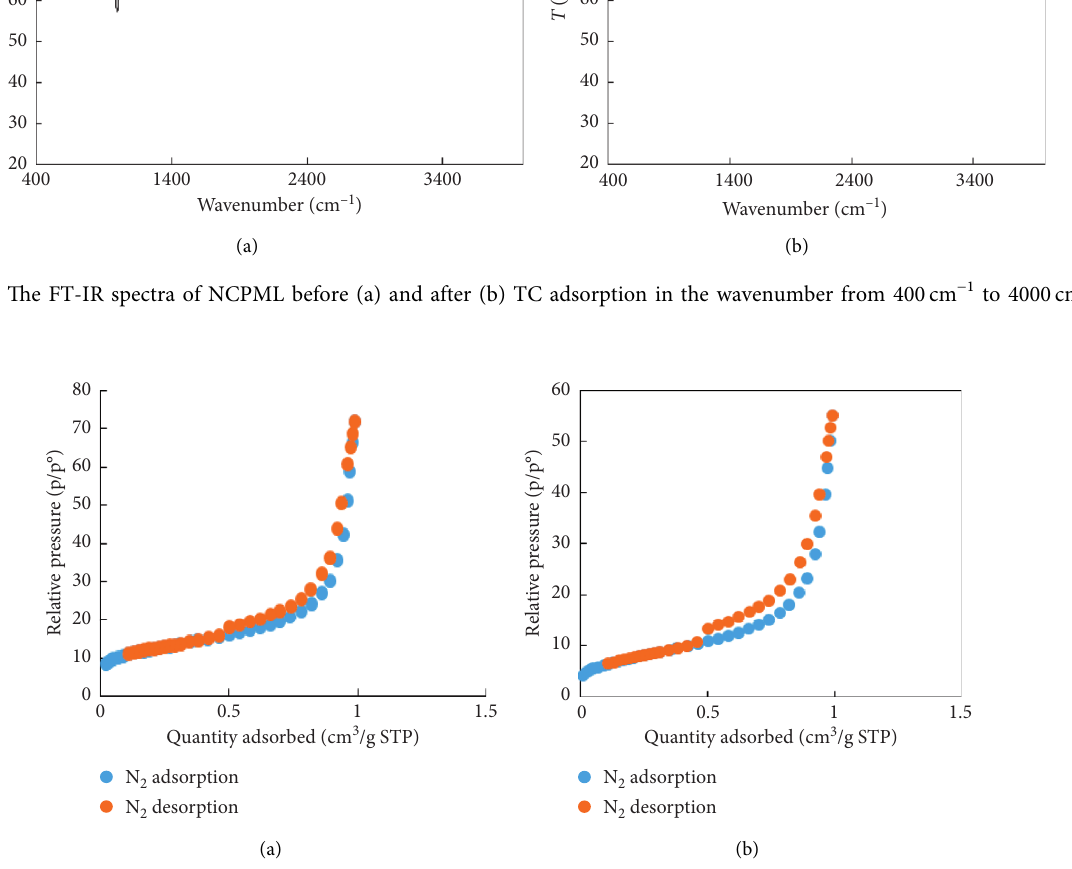
Figure 9: Nitrogen adsorption-desorption isotherms on NCPML before (a) and after (b) TC adsorption. Table 2: Parameters of adsorption kinetics of TC onto